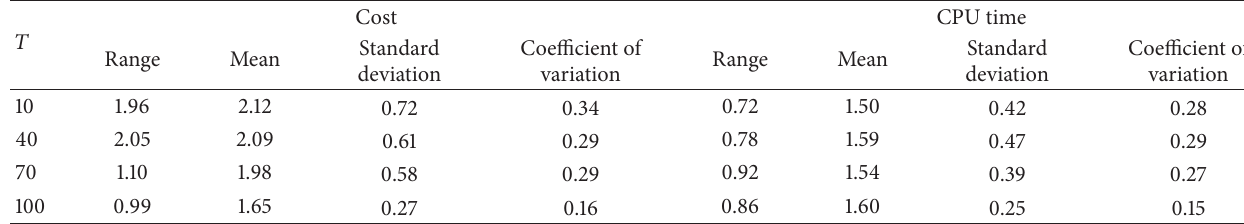
Table 4: The results with different 𝑇 (cost: million yuan, CPU time: